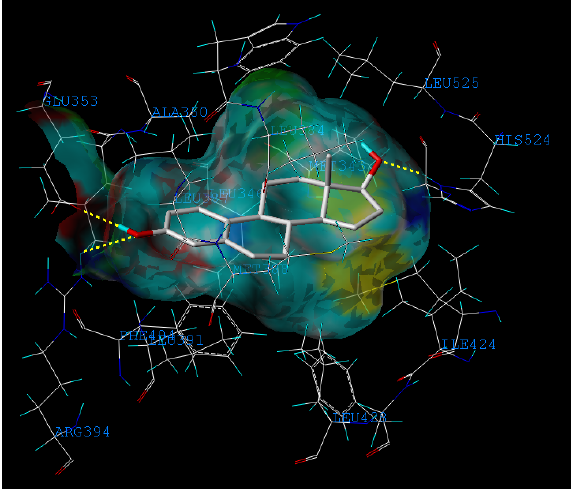
Figure 5. Representation of the binding mode of the E2 into the crystal structure of ER α (PDB code: